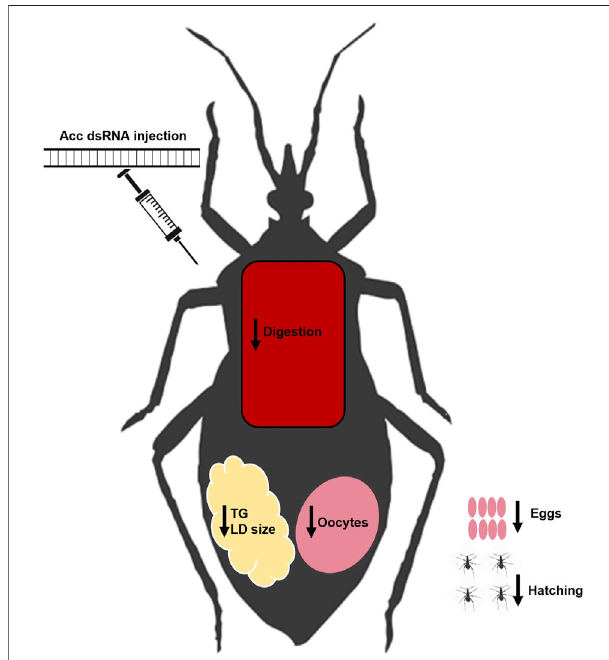
FIGURE8| Summaryofeffectsof Acc knockdown inadultfemalesof R. prolixus. After the inhibition of Acc gene expression by the injection of dsRNA, the fat bodies ofthe AccKD females synthesized and stored lower amounts of lipids, and had smaller lipid droplets. These females laid fewer eggs, which did not hatch and had chorion defects. Although digestion was disturbed,concentrationsofaminoacidsandproteinsinthehemolymphwere not affected. LD: lipid droplet; TG: